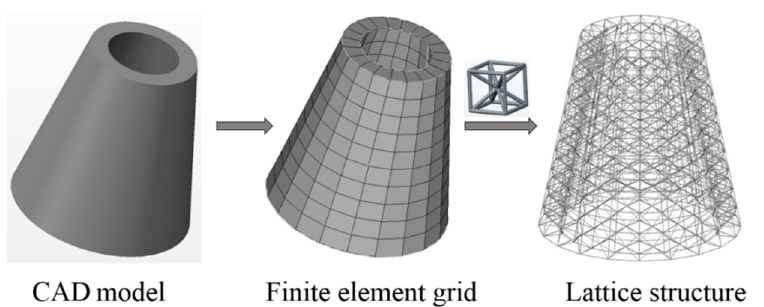
Figure 15. Illustrations of lattice structure generation for hollow round platform.